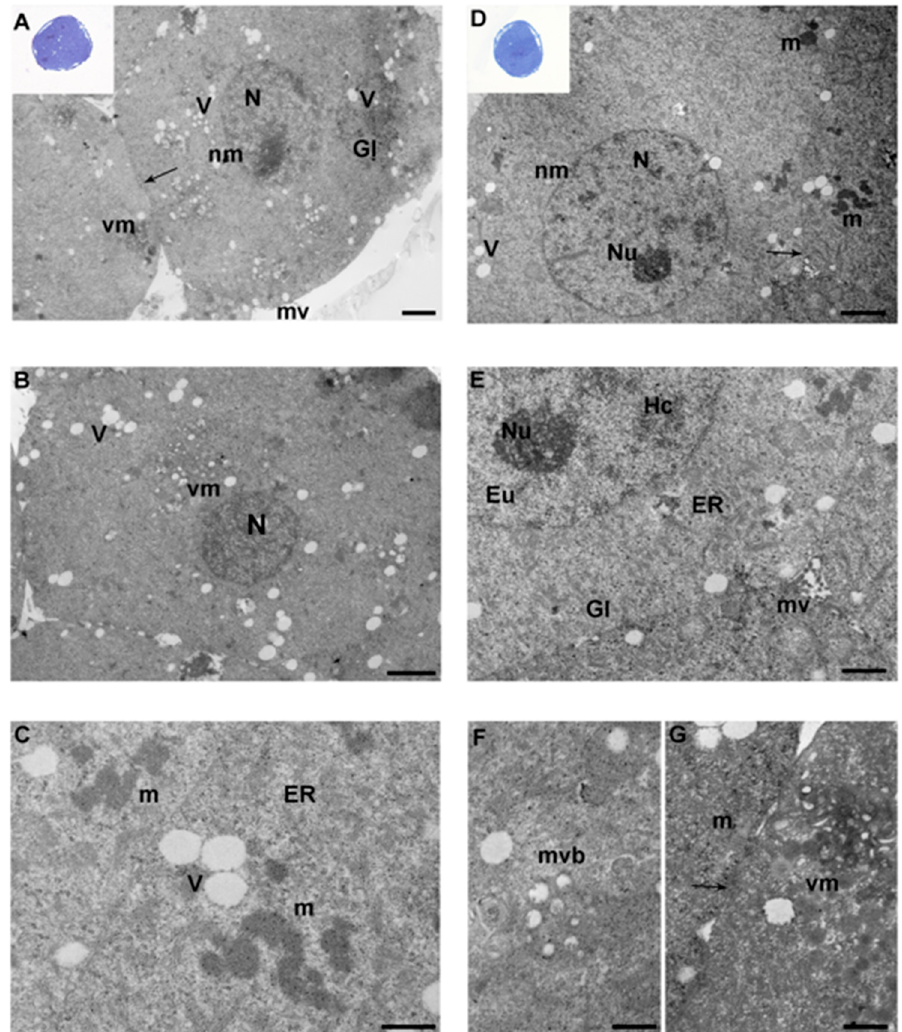
Figure 2. Ultrastructural analysis of morulae. A–C. Representative micrographs of morulae from the control and IVF 5% groups, showing similar morphological features. A. Ultrastructure of the control group morula with large round nucleus (N). Arrow indicates the intercellular contacts. (TEM. Bar: 1 µ m). Inset in A: a representative image of a semithin section of in vivo morula. Numerous blastomeres with well-stained nuclei are visible (LM. Mag: 40x). B. Morula showing numerous vacuoles (V) and vacuolated mitochondria (vm) (TEM. Bar: 2 µ m). C. Representative picture of IVF-5% morula high electron-dense mitochondria (m) and vacuoles (V) (TEM. Bar: 0.6 µ m). D–G. IVF-20% morula ultrastructure. D. Ultrastructure of IVF-20% morula with blastomeres in a compaction stage. Arrows indicate the intercellular contacts (TEM. Bar: 2 µ m). Inset in D. A representative image of a semithin section of IVF-20% morulae (LM. Mag: 40x). E. High magnification of an IVF-20% morula nucleus (N) with evident nucleolus (Nu) and patches of hetero- (Hc) and euchromatin (Eu) (TEM. Bar: 1 µ m). F–G. High magnification of an IVF-20% multivesicular body (mvb) (TEM. Bar: 0.6 µ m) and vacuolated mitochondria (vm) (TEM. Bars: 0.6 and 0.8 µ m). N: nucleus; Nm: nuclear membrane; V: vacuoles; m: mitochondria; vm: vacuolated mitochondria; mv: microvilli; Gl: glycogen granules; ER: endoplasmic reticulum; nu: nucleolus; arrow: intercellular contact; Hc: heterochromatin; Eu: euchromatin; mvb: multivesicular body.